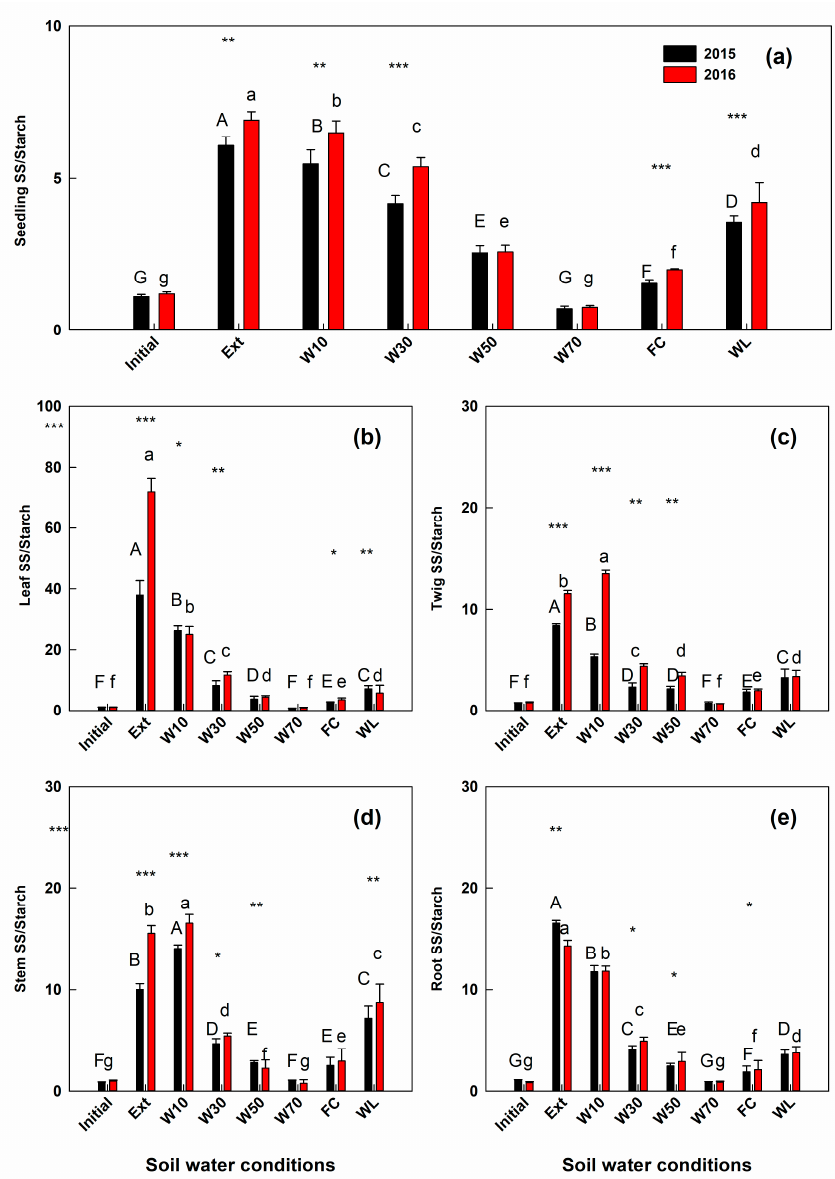
Figure 4. The ratio of soluble sugars (SS) to starch at the end of the 10-day water status treatments in 2015 (black bars) and 2016 (red bars) for ( a ) the whole plant (seedling SS/Starch); ( b ) leaves (leave SS/Starch); ( c ) twigs (twig SS/Starch); ( d ) stem (stems SS/Starch) and; ( e ) roots (root SS/Starch). Values were back-transformed averages, and error bars represent standard errors for the SS/starch of seedlings and tissues. The treatments are Ext: extreme drought, W10: 10% of field capacity (FC), W30: 30% of FC, W50: 50% of FC, W70: 70% of FC, and WL: permanently waterlogged. Asterisks indicate significantly different values (*, p < 0.05; **, p < 0.01; ***, p < 0.001) between 2015 and 2016. Different letters indicate significant differences between treatments in each year. The upper-case letter refers to 2015 and the lower-case letter refers to 2016. Note that the scale used for leaves is different from the scale used for twigs, stems and roots.